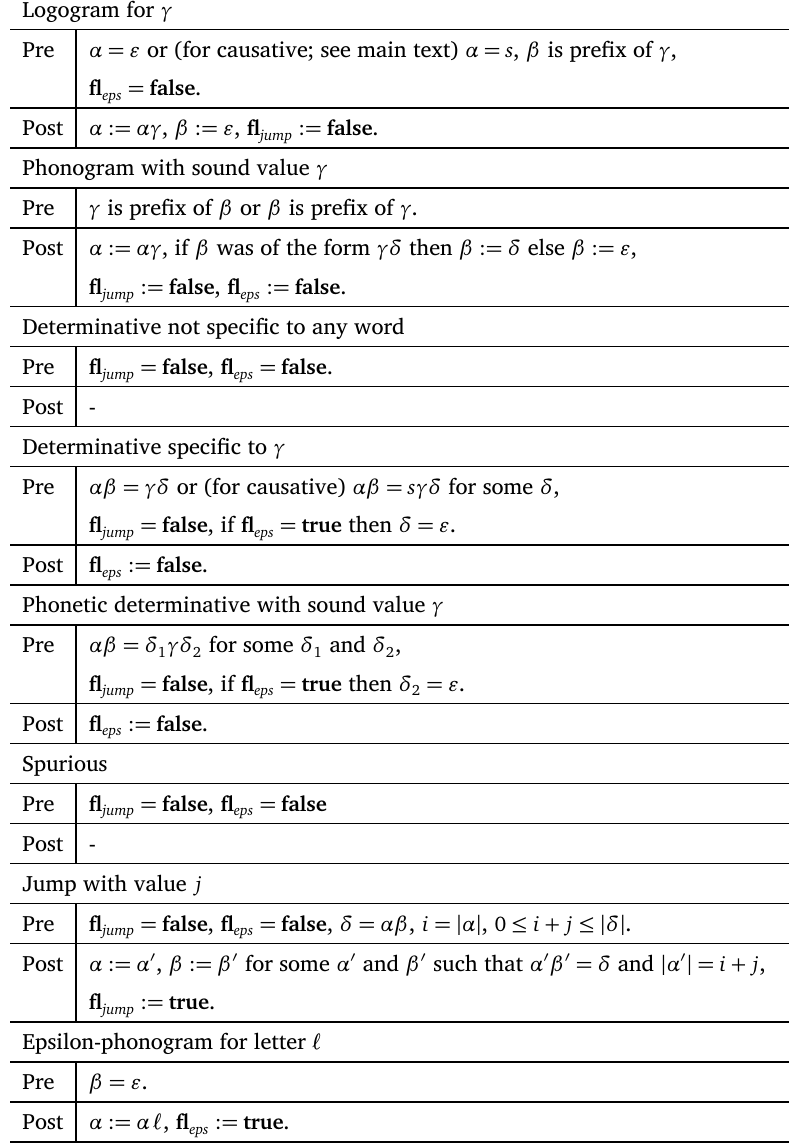
Table 1: Preconditions and